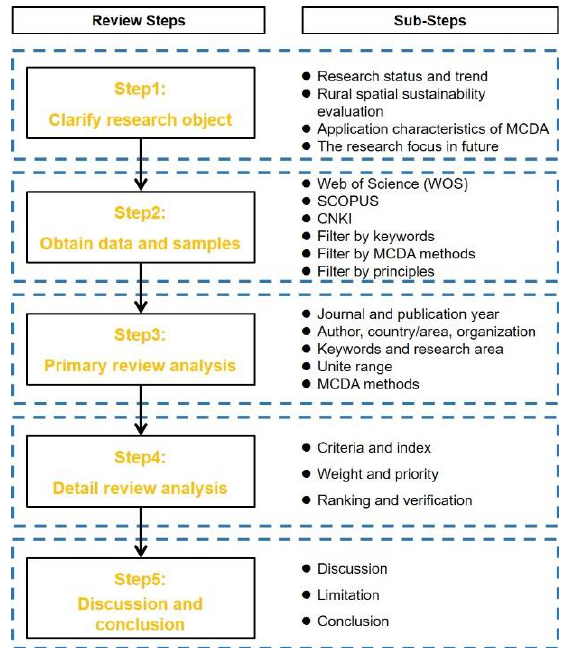
Figure 2. The structure of the research.